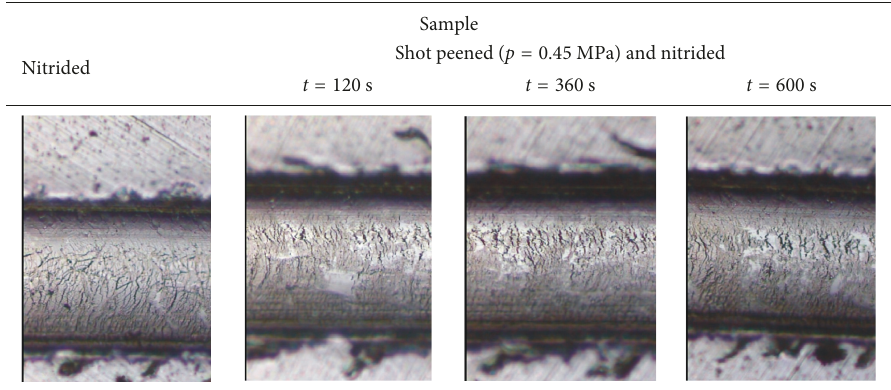
Figure 16: A fragment of the scratches corresponding to the load in the range of 60–65 N for CrN coatings deposited on nitrided substrate and combined shot peening and nitriding process-treated